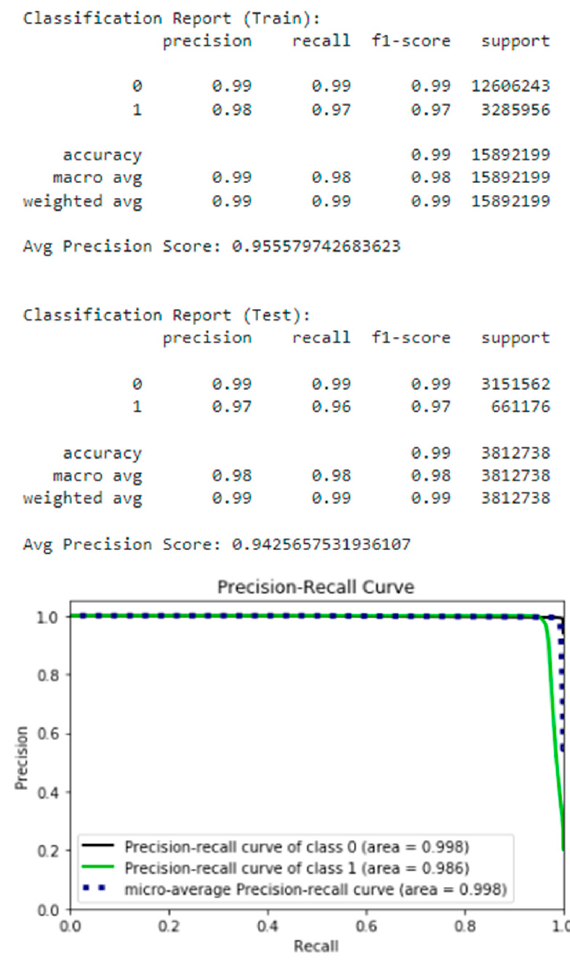
Figure 9. Combined Figure 9. Combined estimator.